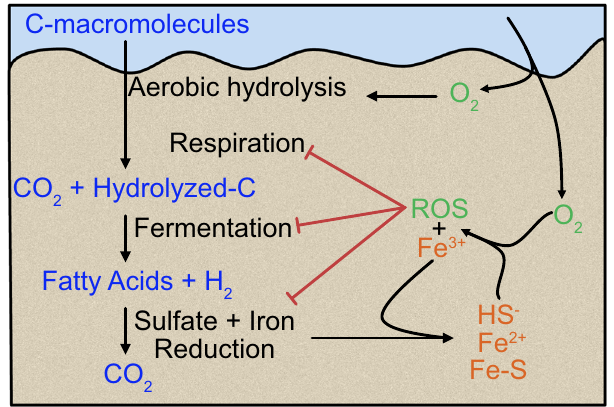
Fig.5|Flowdiagramoftheproposedeffectsofreactiveoxygenspecies(ROS)in intertidal sands. Arrows represent transport and production processes. Red lines represent limiting effects. Organic material in the form of macromolecules is transported into the sediments. Hydrolysis and fermentation convert these mole- cules into e.g., fatty acids and hydrogen, which are substrates for sulfate and iron reducers.Also,oxygen(O 2 )istransportedintothesediments,whereitcancomein contact with reduced sulfur and iron, resulting in, among others, ferric iron (Fe 3+ ) and ROS. ROS in fl uence biotic reactions with organic material. Sulfate- and iron reduction are limited either indirectly via fermentation, or directly, which is not further assessed in this